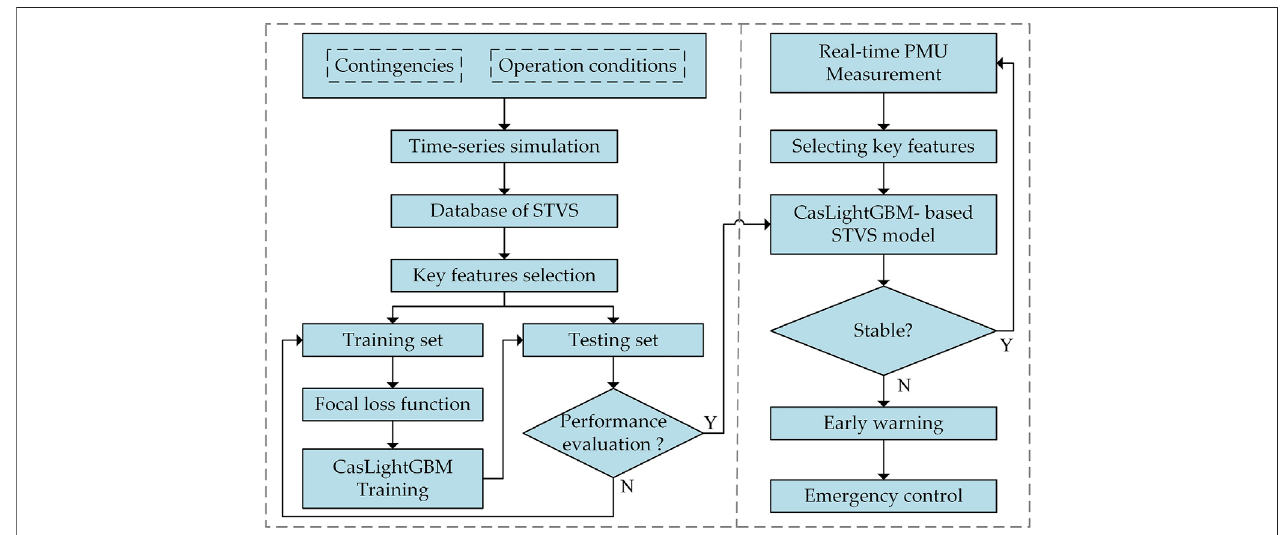
FIGURE 4 | The framework of the proposed